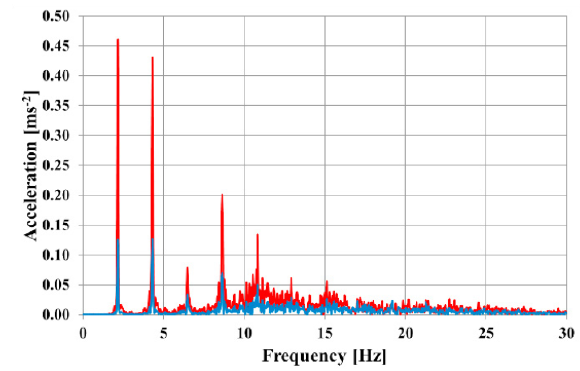
Figure 10. Frequency at Eden in 2016